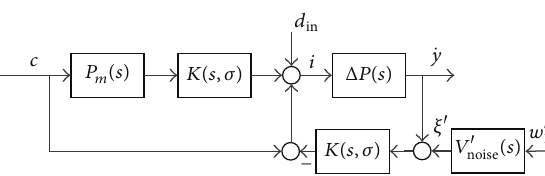
Figure 6: Internal loop with uncertainty models Δ𝑃 .